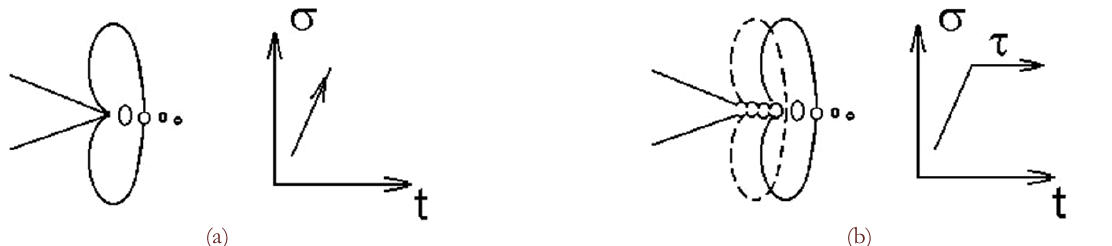
Figure 6: The propagation sequence (schematic) of a fatigue crack under (a) increasing or (b) constant applied load with a result that a dimpled fracture is formed